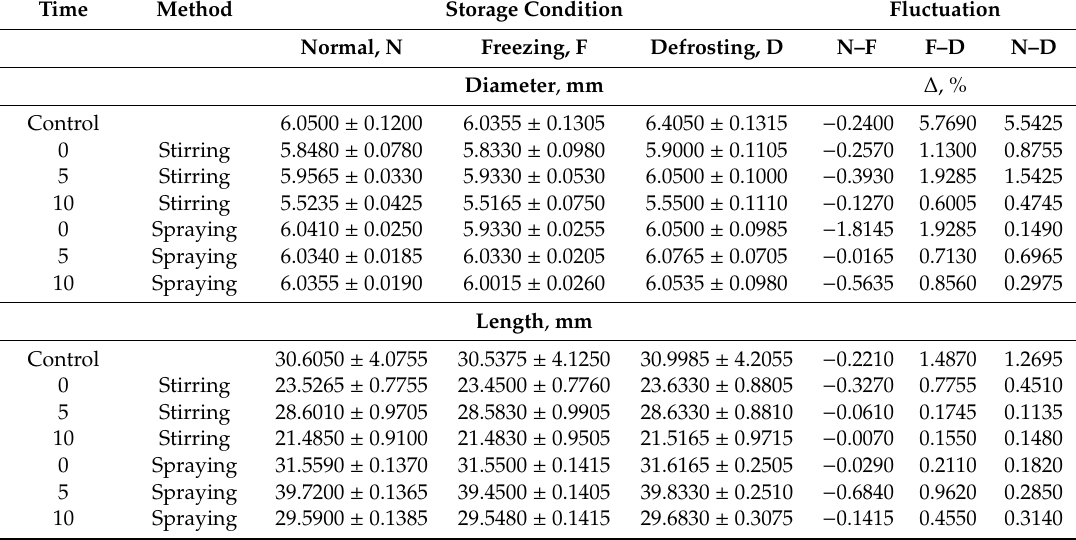
Table 2. Descriptive analysis for the diameters and lengths of non-wood pellets with addition by stirring or spraying of liquid-state food waste subjected to the process of